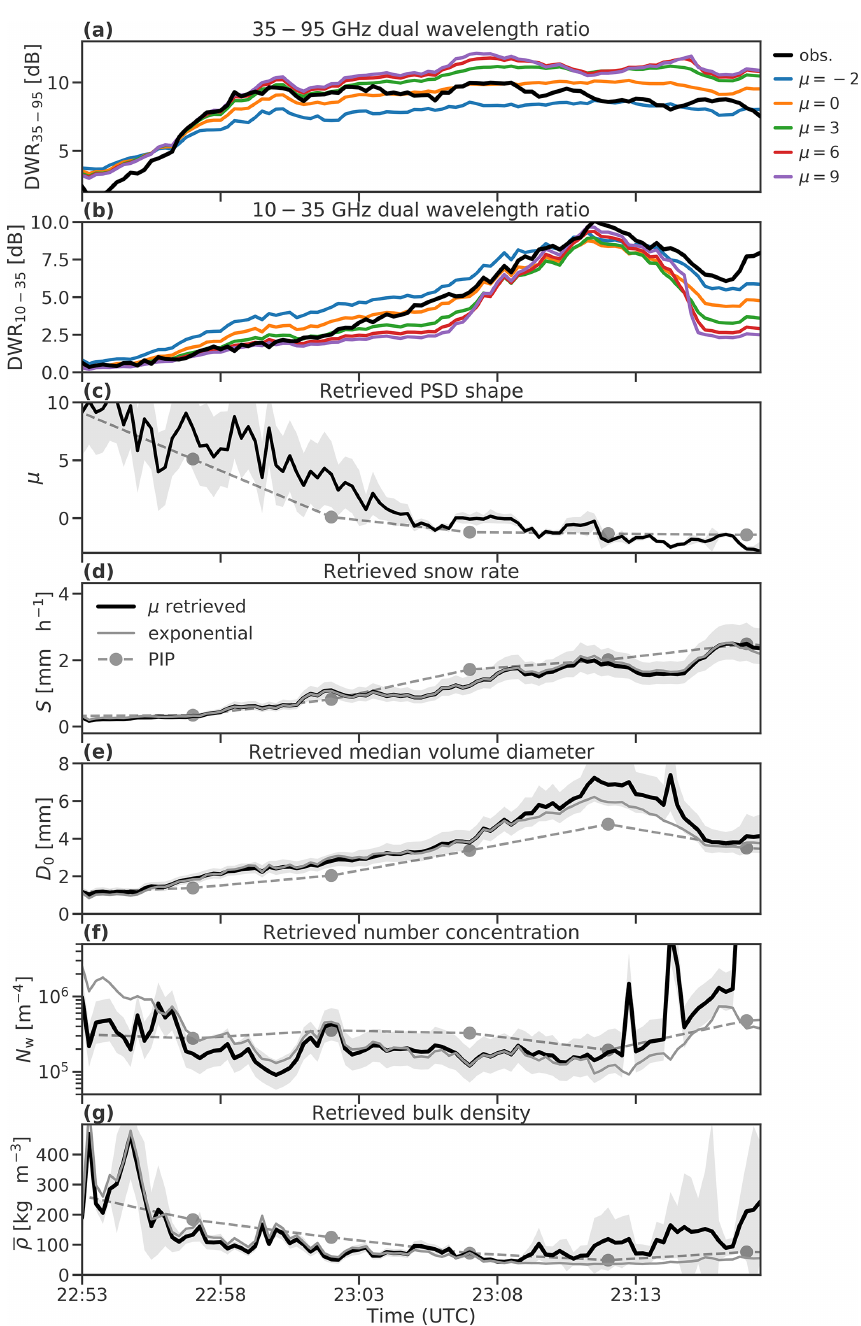
Figure 10. Measured and forward-modelled (a) DWR 35–95 and (b) DWR 10–35 at 500m above ground level for CAPTIVATE retrievals assuming a range of PSD types; (c) the retrieved PSD shape parameter compared against that estimated from in situ measurements at the surface by PIP; and (d) snow rate, (e) median volume diameter, (f) normalized number concentration, and (g) bulk density comparing values for the pseudo-retrieval against one in which exponential PSDs are assumed. Shaded regions represent the uncertainty in the retrieved